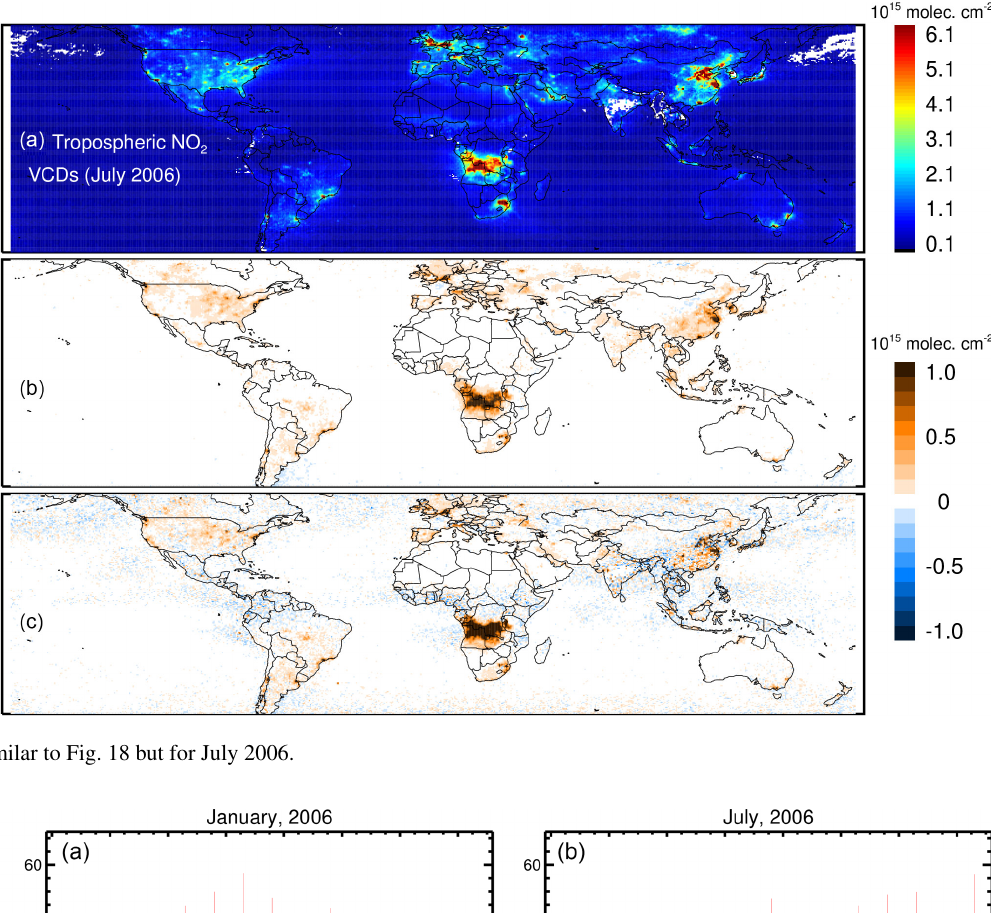
Figure 19. Similar to Fig. 18 but for July 2006.